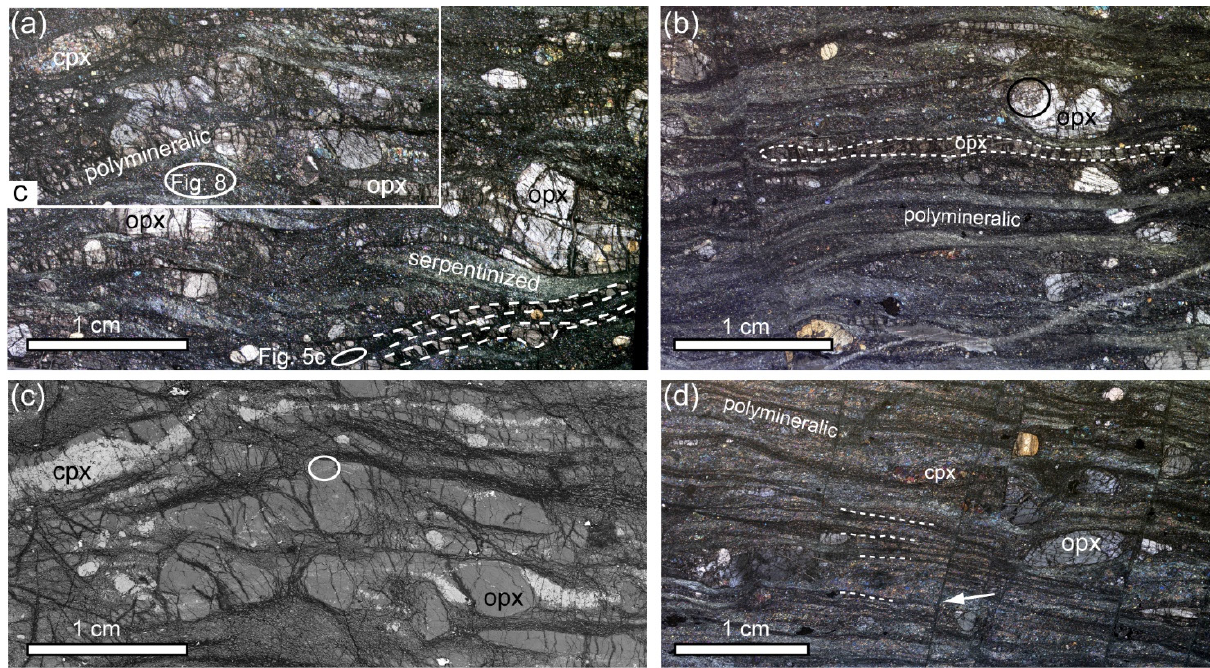
Figure 2. Overview of the thin sections. ( a ) Optical microscope image of Sample 6.6 under crossed polarized light. Opx porphyroclasts and some cpx porphyroclasts are visible, within an olivine-rich matrix. There are several fine-grained polymineralic layers visible (dashed white lines). Some of the opx porphyroclasts are elongated. Indicated is the location of Figure 5c (white ellipse) and the olivine matrix analyzed with EBSD displayed in Figure 8 (white ellipse); also indicated is the location of ( c ). ( b ) Optical microscope image of Sample 8.4 under crossed polarized light. The sample is similar to Sample 6.6 but shows fewer opx porphyroclasts and an increasing amount of fine-grained polymineralic layers. Some opx porphyroclasts are elongated as shown by the stippled line. Some opx porphyroclasts are recrystallized (black circle). ( c ) Part of ( a ) as backscatter electron (BSE) image. The bright phase is cpx, the medium gray is olivine/opx and the dark is serpentine. The polymineralic layers contain cpx as indicated in the white circle. All the cpx porphyroclasts show tails of smaller, cpx ± olivine neoblasts. ( d ) Optical microscope image of Sample 8.3 under crossed polarized light. Thin dark layers parallel (dashed lines) to the olivine matrix are fine-grained polymineralic layers. The sample also shows later stage vertical fractures that offset these thin layers (white arrow).